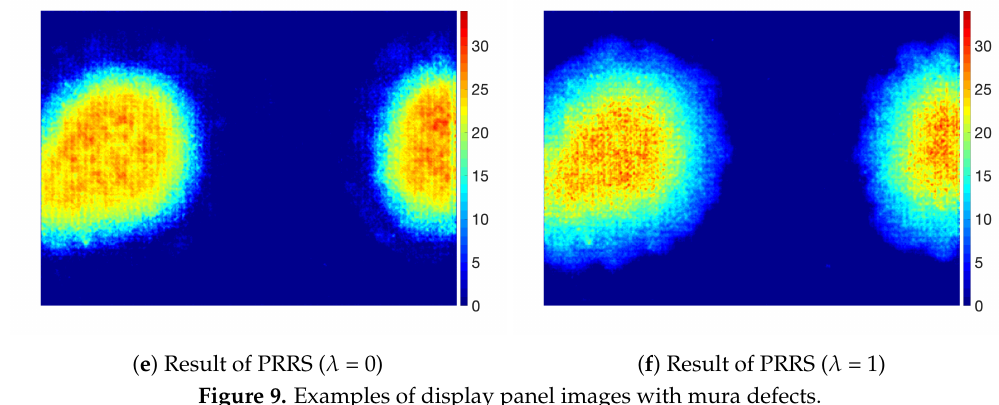
Figure 9. Examples of display panel images with mura defects.